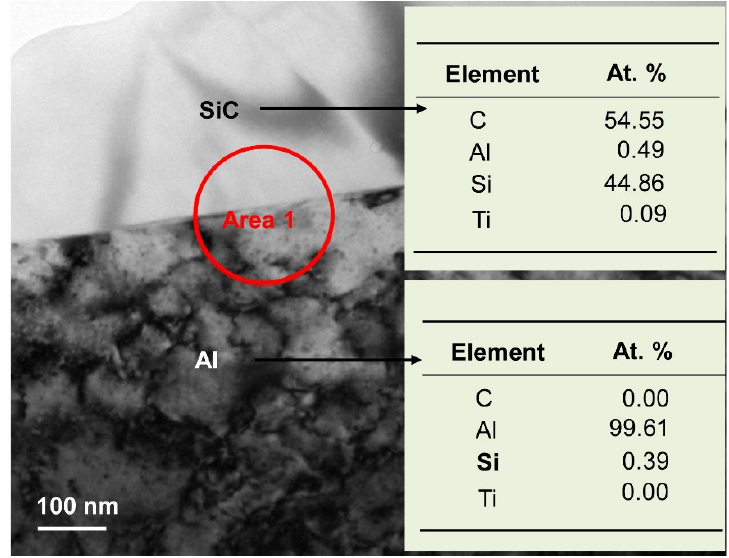
Figure 8. Cross-sectional TEM image with EDS analysis of the SiC–Al interface.